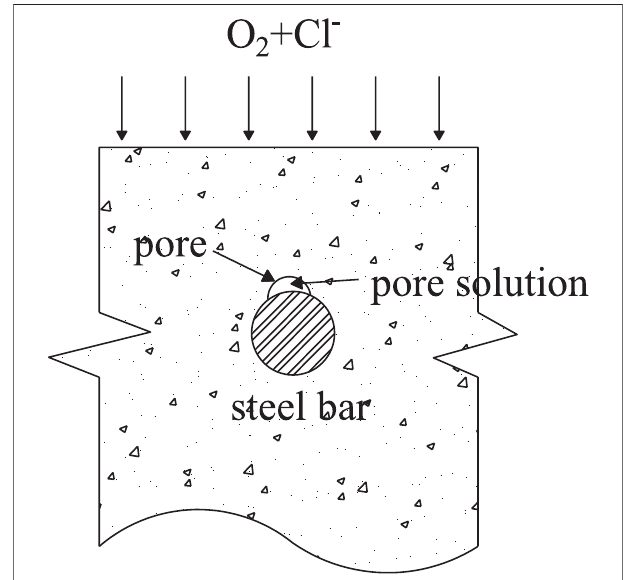
FIGURE 3 | Corrosion mechanism of steel bar in concrete.